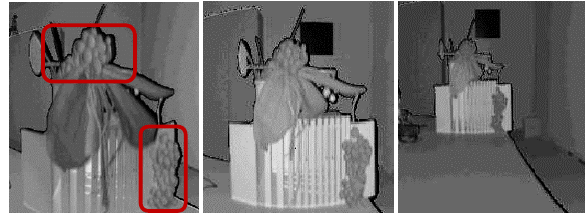
Figure 5: Intensity images for object distances of approximately 25 cm, 50 cm and 1 m (from left to right). The red boxes highlight the regions of interest, i.e. the regions with bunches of grape berries.